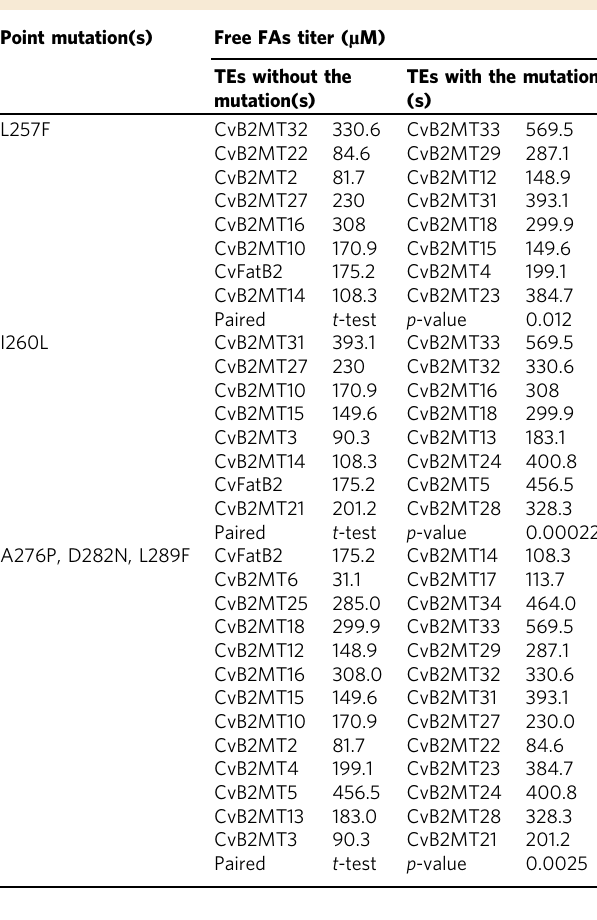
Table 1 Pair-wise comparison of total free FAs in the medium produced by E. coli strains expressing pairs of TE mutants that differ only by the presence or absence of speci fi c point